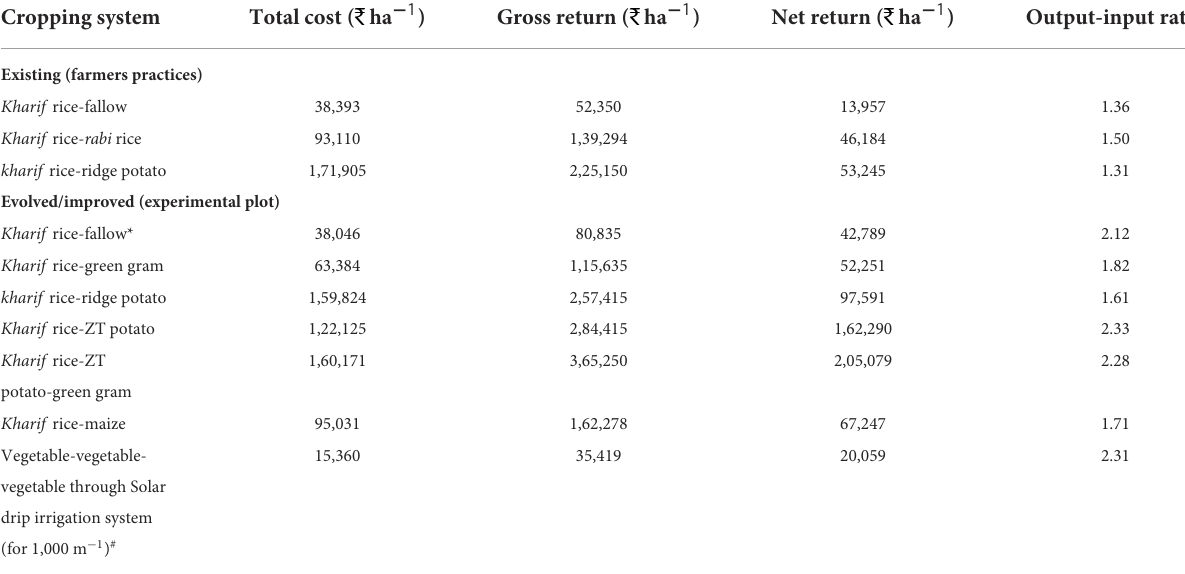
TABLE 1 Cropping system intensifications and profitability in coastal zone of West Bengal, India. Cropping